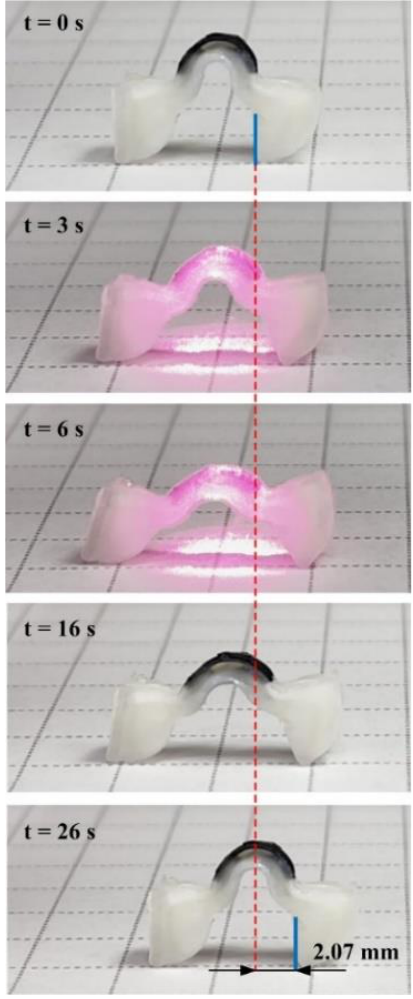
Figure 9. The experimental setup for measuring the crawling locomotion of devices.